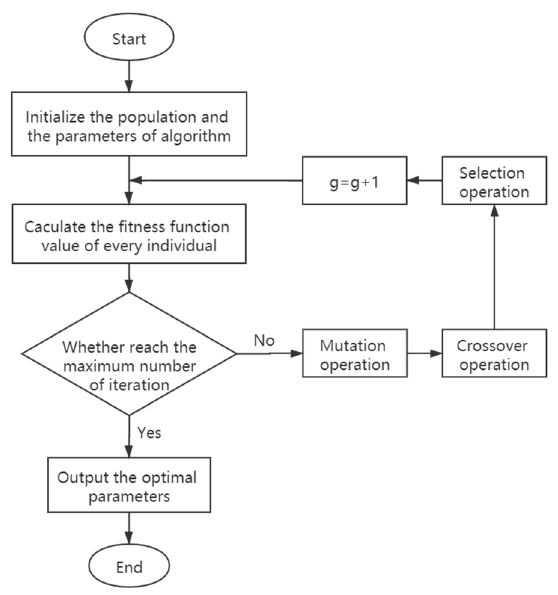
Figure 7. Algorithm flow of differential evolution ELM (DE-ELM) model.